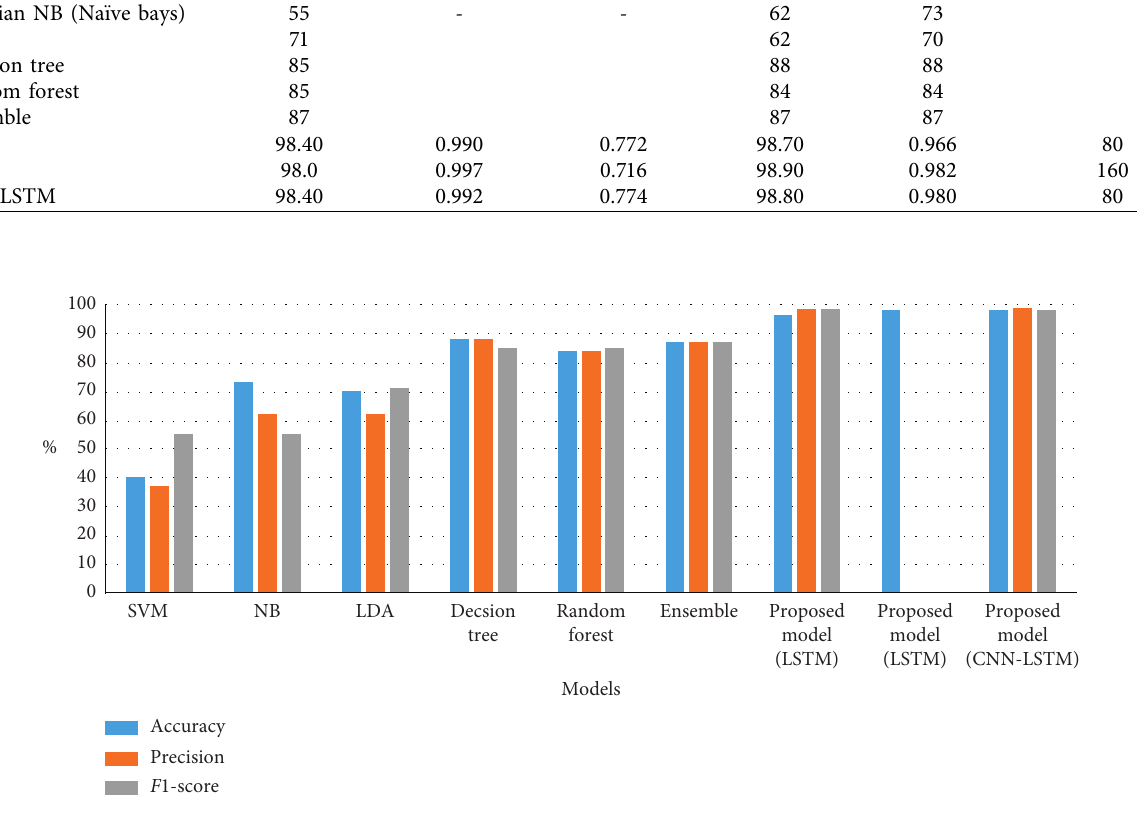
Figure 16: Comparison of the proposed system against the existing system in terms of accuracy metric.